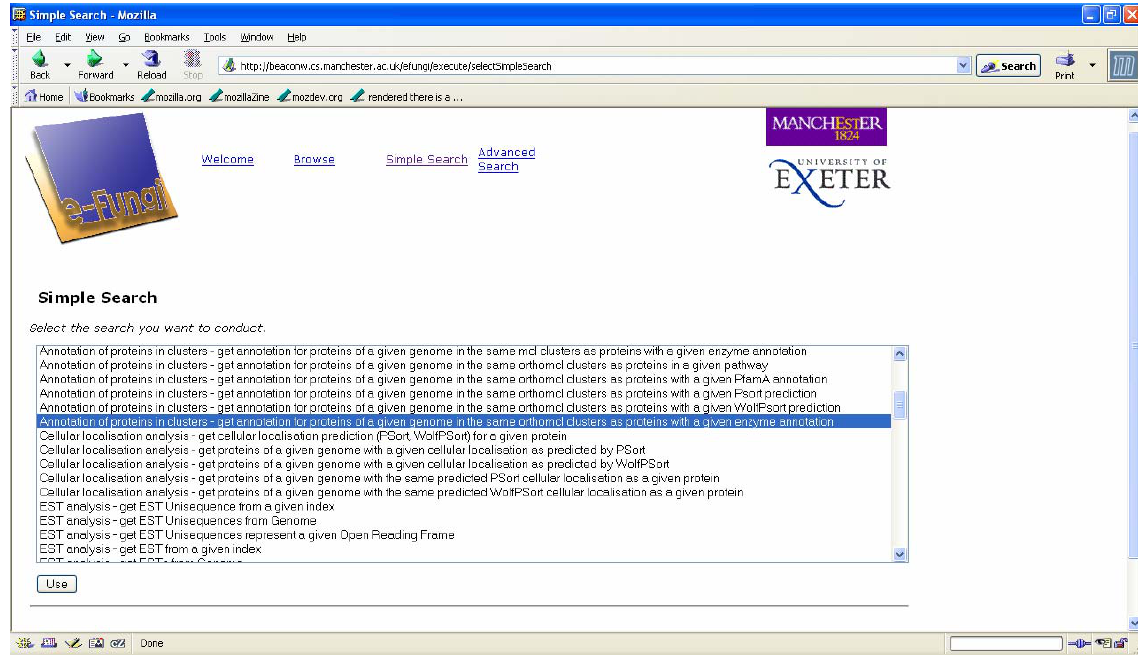
Figure 7: Selecting a canned query in